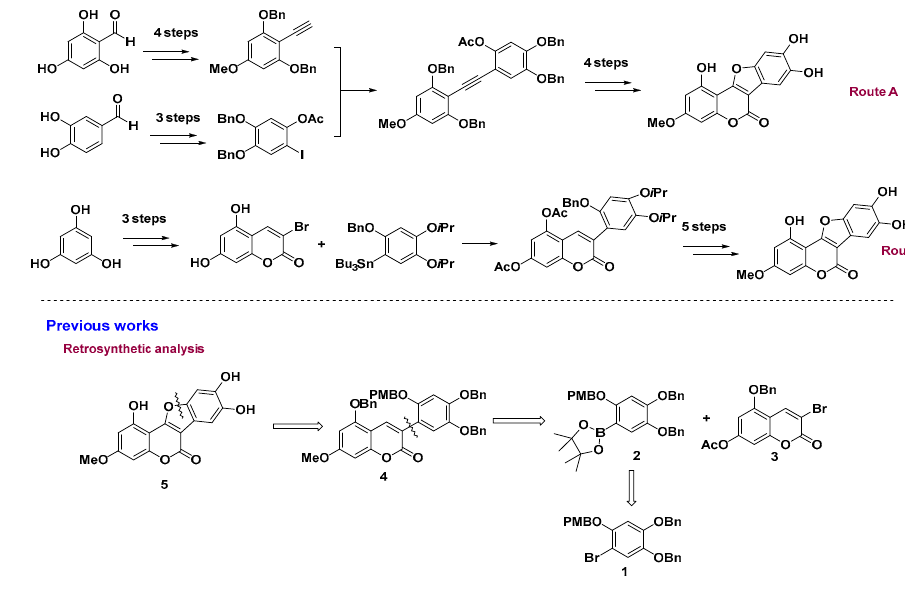
Figure 1. Reported synthesis routes of wedelolactone (WEL) and our proposal.